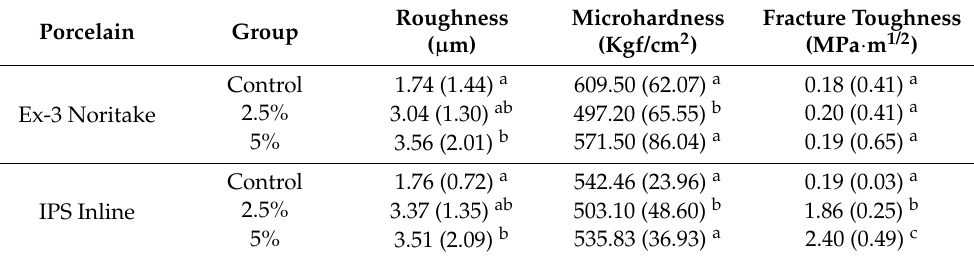
Table 3. Mechanical behavior of dental porcelains incorporated with β -AgVO 3